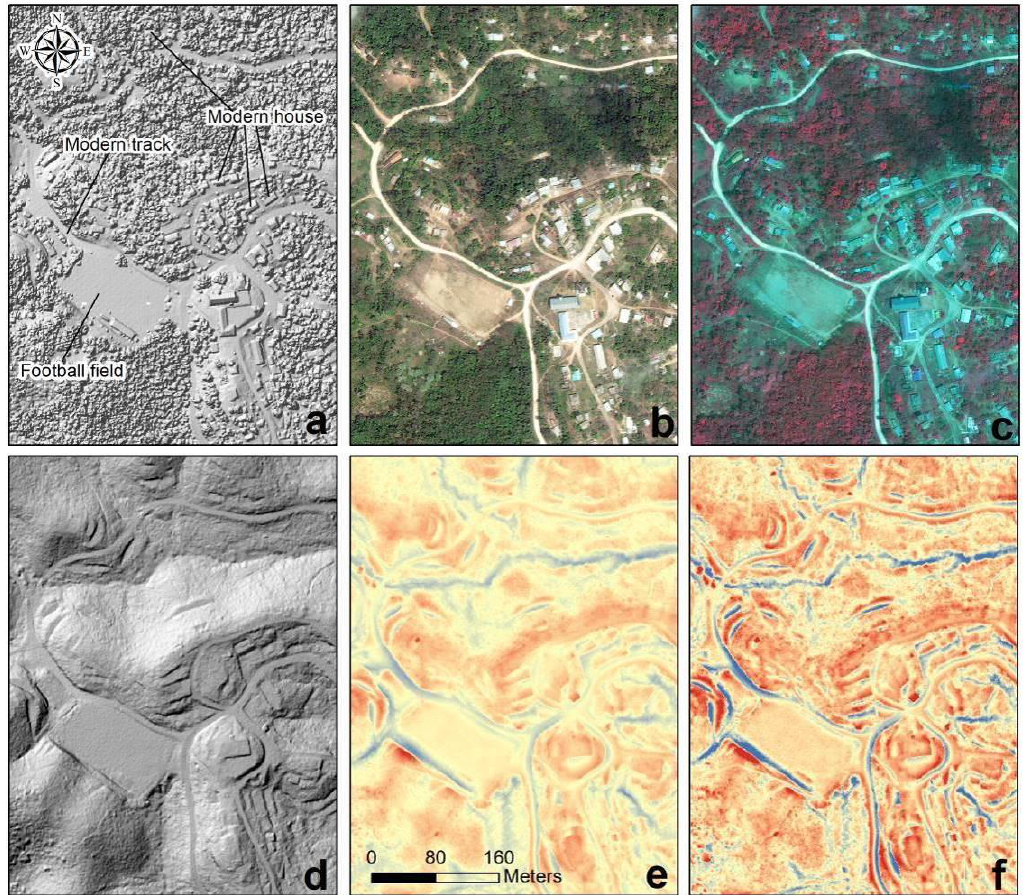
Figure 11. The visual effect of anthropogenic landscape modifications on the ( a ) DSM, ( d ) DTM, ( e ) TPI, and ( f ) SLRM, which should be considered during the remote detection of archaeological features. The GeoEye-1 satellite image in ( b ) color and ( c ) FCIR show the location of structures, roads and tracks, and modified landscapes.